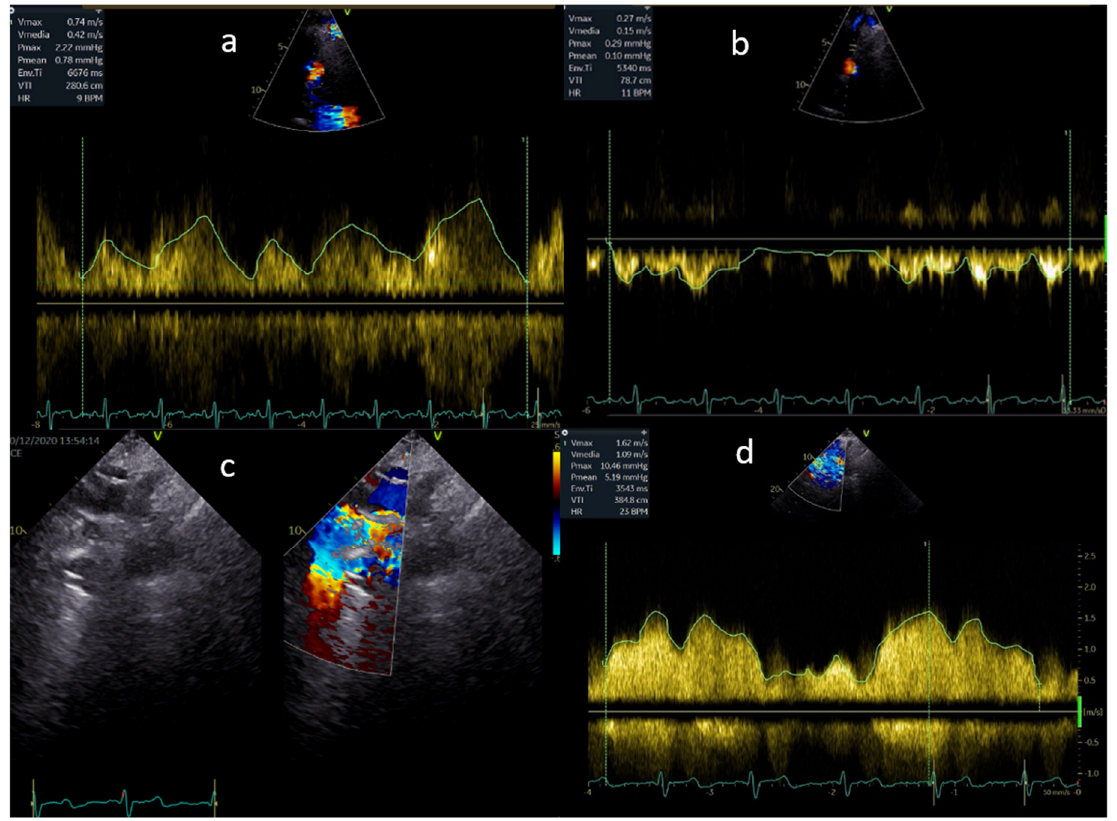
Figure 2. ( a , b ) Normal flow in the Fontan pathway; ( c , d ) mild flow acceleration through a stented extracardiac